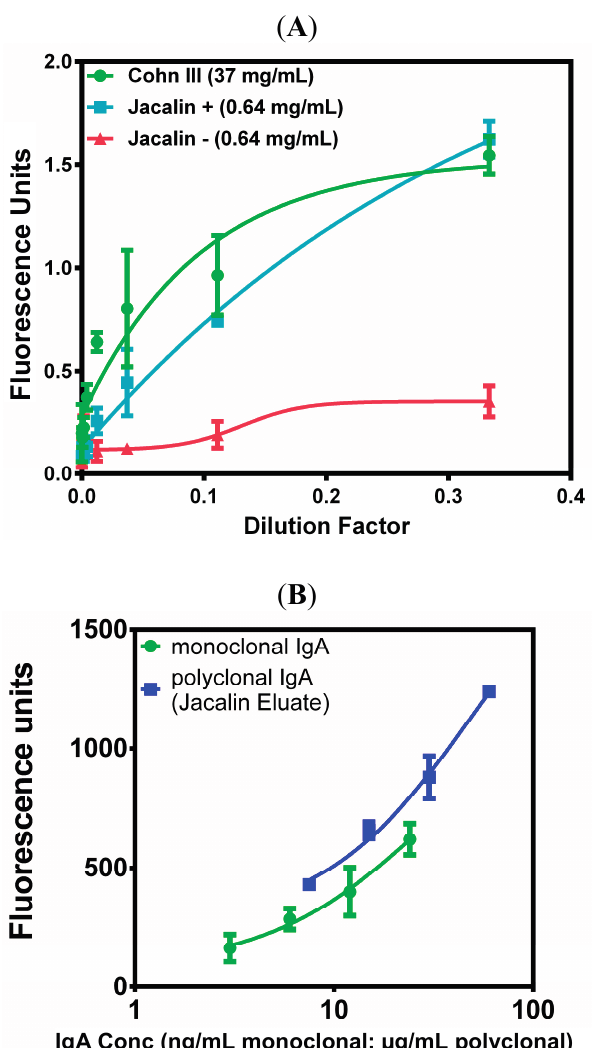
Figure 2. Figure 2 shows IgA anti- C. difficile Toxin A ELISAs. Both the crude Cohn fraction III preparation (green line, green dots) and the jacalin eluate containing polyclonal plasma-derived IgA (blue line, blue squares) demonstrated binding to C. difficile toxin A (bound to the plate) by ELISA, while the jacalin flow-through protein fraction (red line, red triangles) did not (Figure 2A). This demonstrates that anti- C. difficile toxin A binding activity isolated from Cohn fraction III is IgA. Figure 2A shows the fluorescence units at sequentially lower dilutions beginning at a 1:10 dilution (0.1 dilution factor), 1:5 dilution (0.2 dilution factor), etc . Cohn FxIII: resolublized Cohn fraction III precipitate; Jacalin +: jacalin (jack bean lectin) IgA eluate; Jacalin -: jacalin flow-through. The figure ( B ) shows the anti -C. difficile Toxin A binding (CdtA is bound to the plate) of plasma derived polyclonal IgA and monoclonal anti-CdtA IgA which is used as a positive control (Blaise Corthesy, Lausanne, Switzerland). The figure ( C ) shows the relative anti - CdtA and CdtB binding of plasma derived polyclonal IgA (CdtA or CdtB is bound to the plate); mAB: monoclonal antibody; pAb: polyclonal antibody; anti-CdtA: anti -C. difficile Toxin A; anti- CdtB: anti -C. difficile Toxin